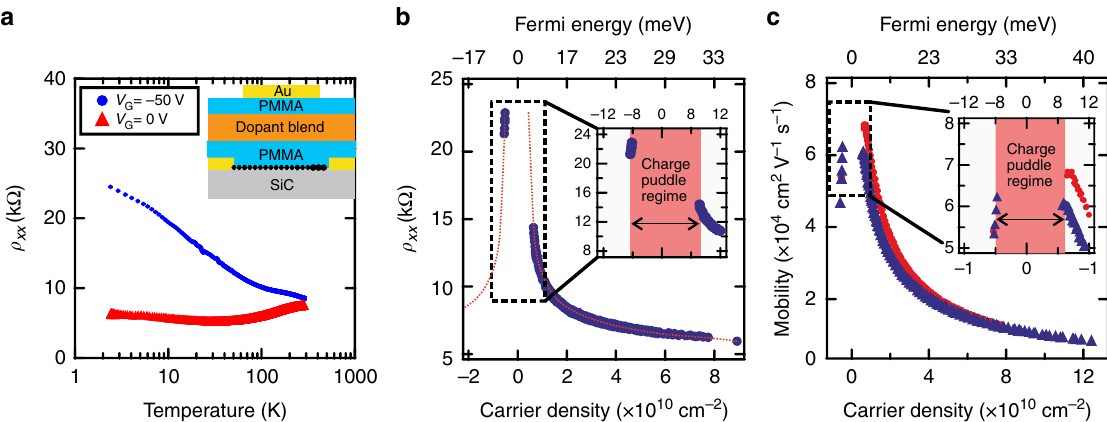
Fig. 3 Electrostatic gating of chemically doped graphene (30 μ m × 180 μ m Hall bar). a Temperature dependence of longitudinal resistance for graphene in the metallic limit (red) and gated to Dirac point (blue). (Inset) Schematic representation of a chemically doped graphene device with a metallic gate (the topmost Au layer). b ρ XX vs. carrier concentration shows the characteristic Dirac peak around the charge neutrality point (red dotted line serves as a